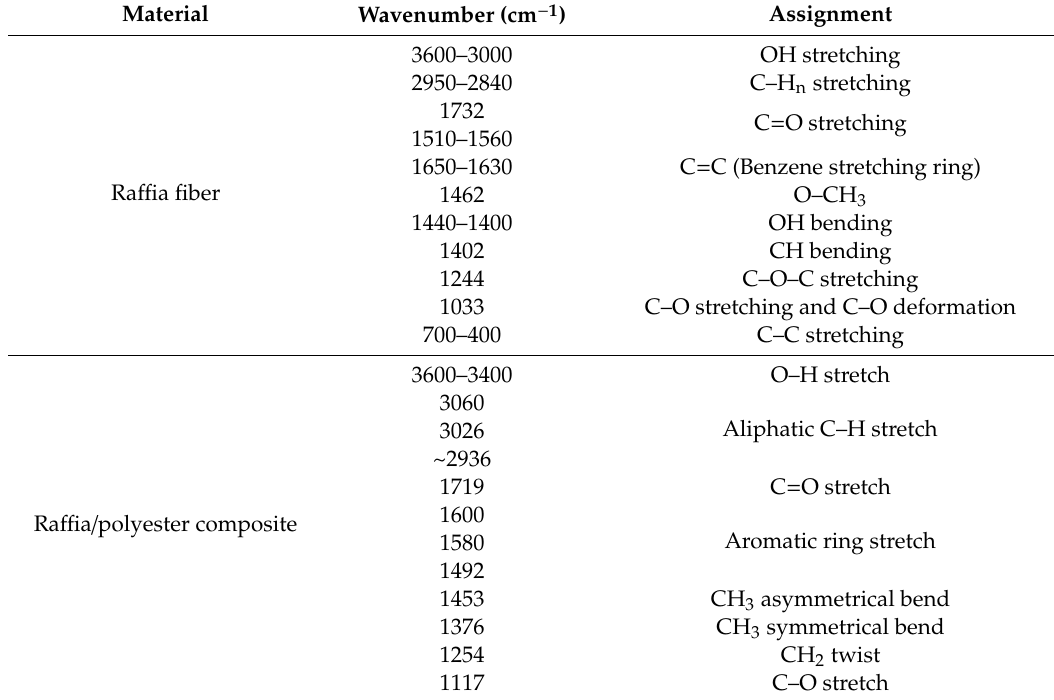
Table 5. Assignment of the main FTIR bands of ra ffi a fiber and its polyester